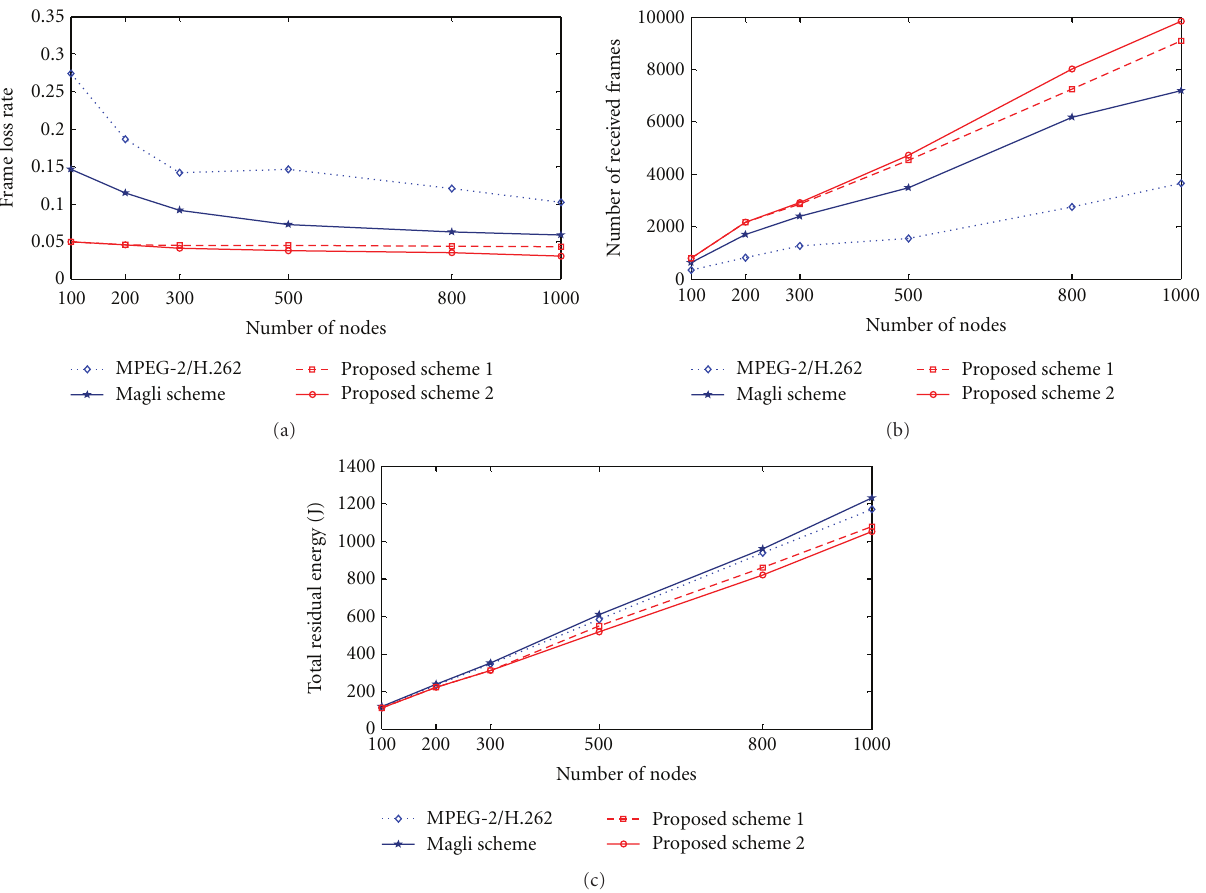
Figure 15: The results obtained for four schemes with QCIF Akiyo video in case of not having channel error: (a) the average frame loss rate, (b) the number of received frames, and (c) the total residual